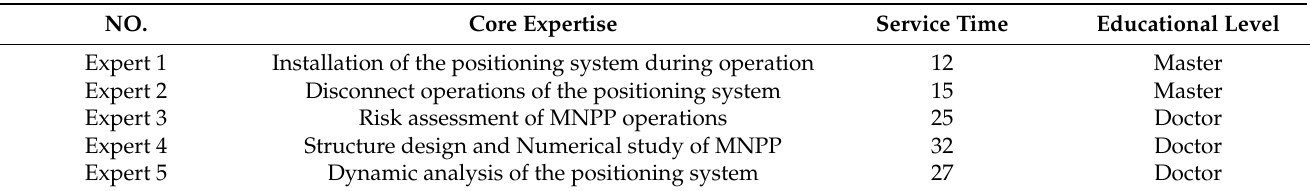
Table 1. Experts’